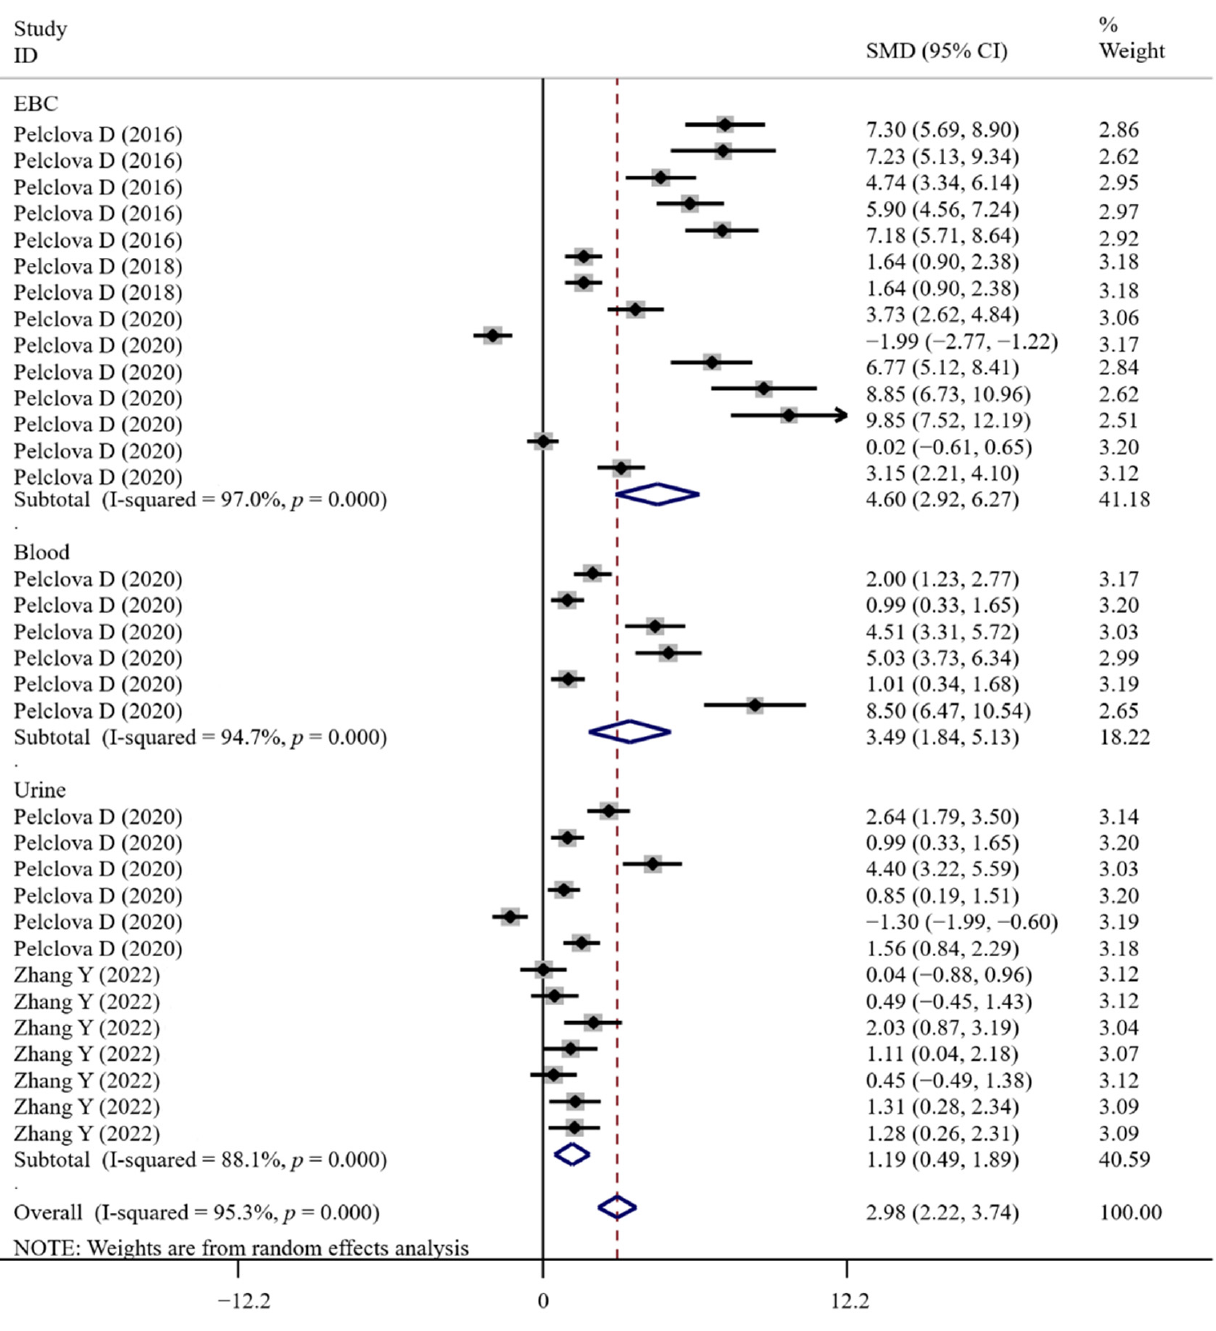
Figure 6. Forest plots assessing the effects of NM exposure on the level of 8-OHG in different samples compared with the non-exposed control group. NMs, nanomaterials; EBC, exhaled breath condensate; 8-OHG, 8-hydroxyguanine; SMD, standardized mean difference; CI, confidence interval [15,29,33,43,44].